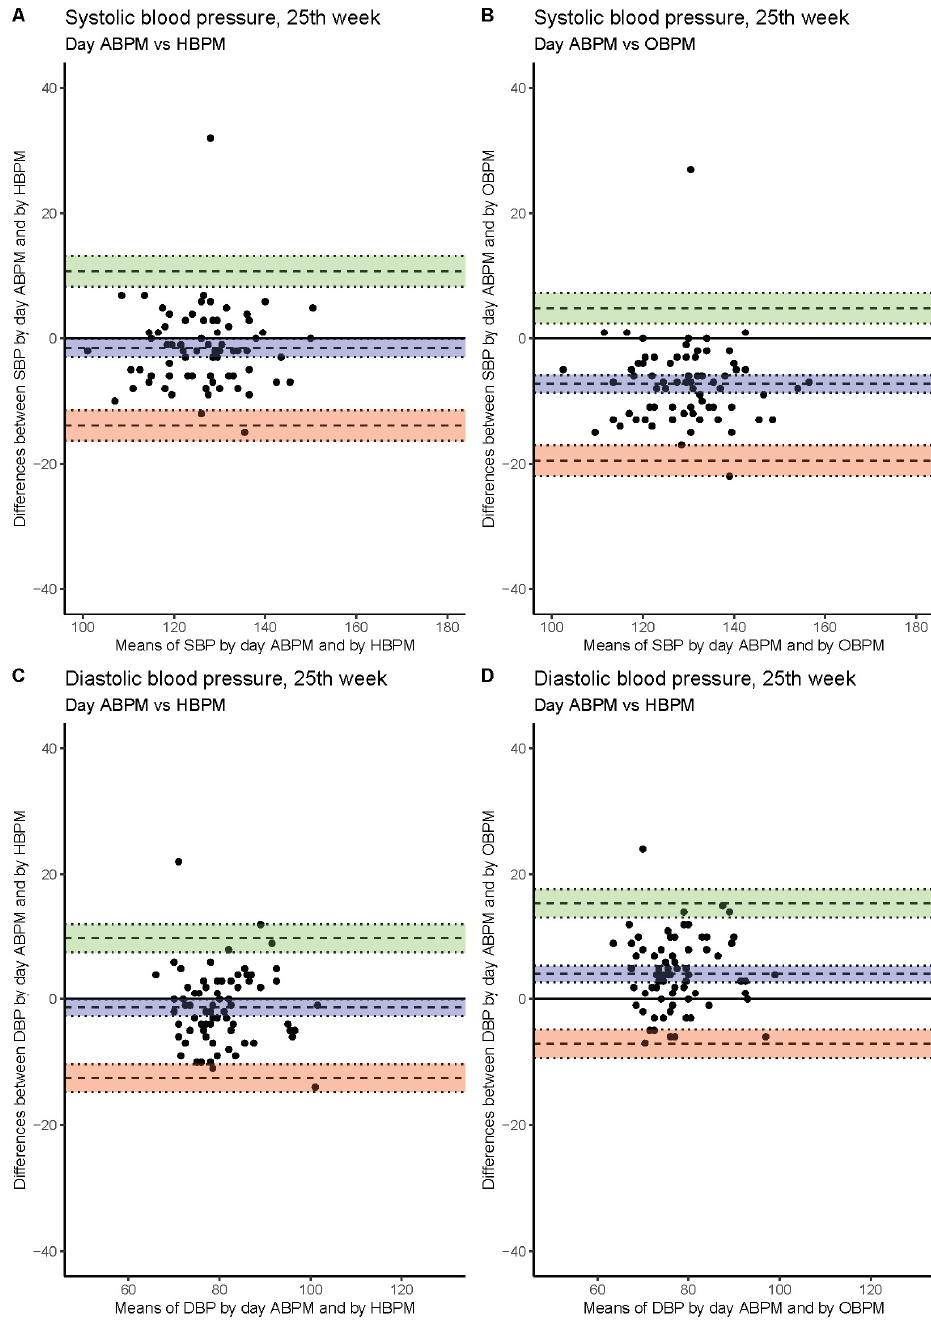
Figure 2. The agreement between systolic blood pressure values obtained by day ABPM vs. HBPM ( A ) and day ABPM vs. OBPM ( B ). Diastolic blood pressure measured by day ABPM vs. HBPM ( C ) and day ABPM vs. OBPM ( D ) in 25th week of gestation. For each patient difference and mean of blood pressure values obtained by two methods was calculated and plotted (black dots). Mean of differences is presented as bias with computed 95% confidence interval (blue). Upper and lower limit of agreement with 95% confidence intervals are presented using green and pink colors, respec- tively.